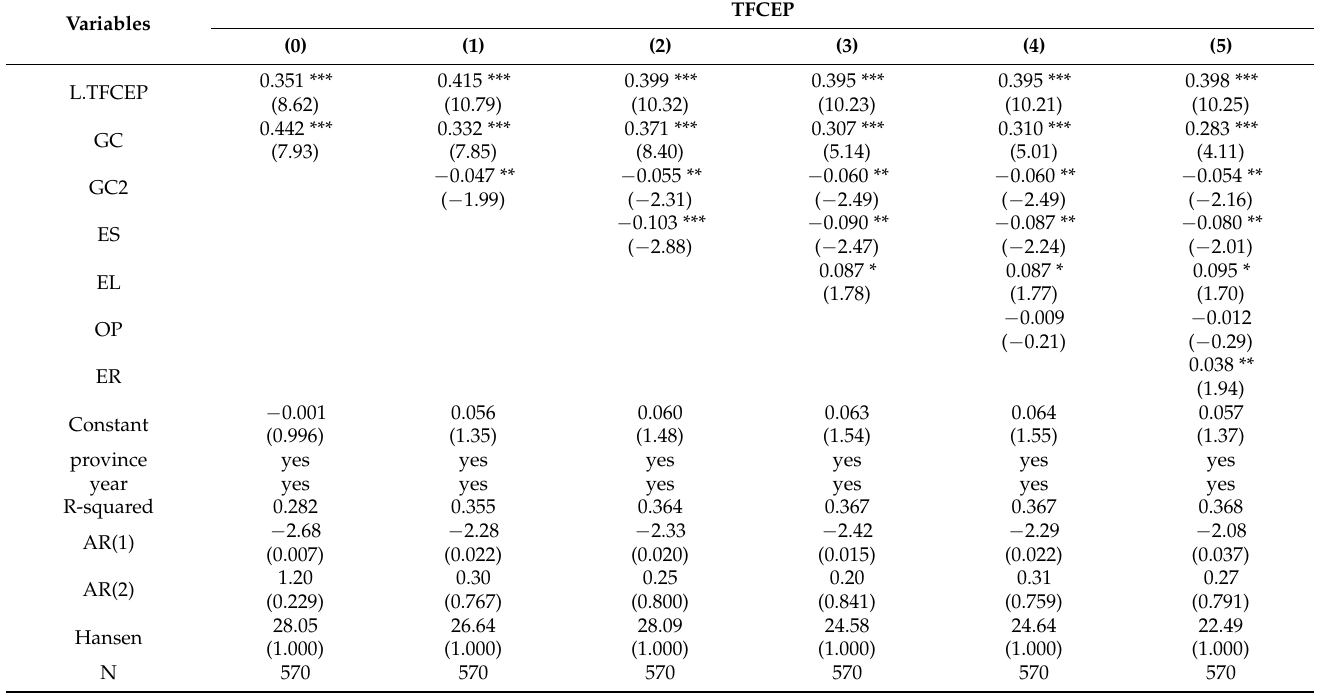
Table 2. SYM-GMM estimation results of green credit and